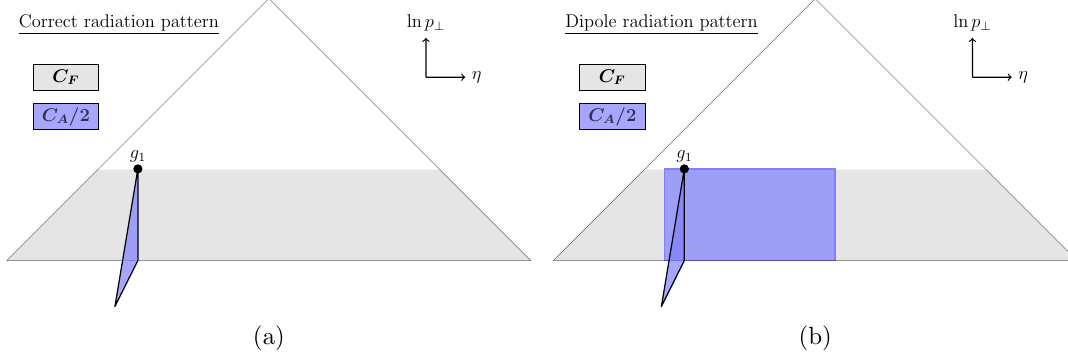
Figure 2. Lund-diagram illustrations of the subleading- N C issue in the showers that we consider. As a starting point we take a right (left)-moving quark (anti-quark), and gluon g 1 emitted at the (cid:17) (cid:0) ln p ? coordinate shown in the big (\primary") triangle. The phase-space for emission of a further gluon from the qg 1 dipole corresponds to the shaded area to the right of g 1 on the primary triangle, and the right-hand face of the \leaf" that comes out of the plane; analogously the phase-space for emission from the (cid:22) qg 1 dipole corresponds to the shaded area of the primary triangle to the left of g 1 and to the left-hand face of the leaf. The colour factor associated with the phase-space region is indicated by the colour of the shading: grey denotes C F , while blue denotes C A = 2. The left-hand diagram shows the correct pattern, the right-hand diagram shows the outcome of the Pythia and Dire